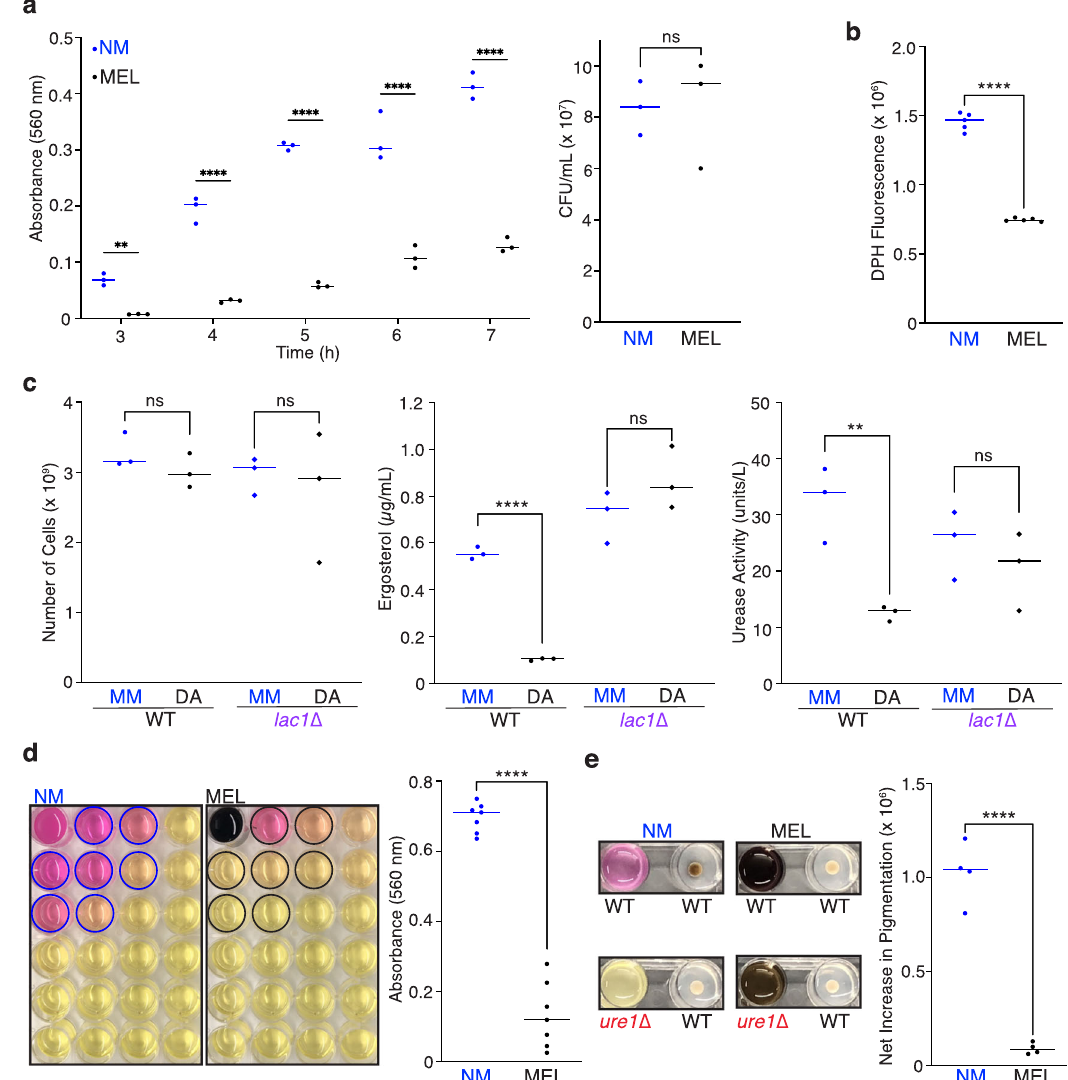
two-sided parametric t -test) and urease activity (right panel; n =3, NS not sig- ni fi cant, ** p =0.0074; unpaired, two-sided p arametric t -test) for WT but not lac1 Δ cellsgrowninthepresenceofDA. d 24-wellplates(left)withNMorMELcellsinurea broth in well A1 (upper left) and pH-sensitive media in remaining wells photo- graphed after incubation at 30°C for 24h. Scatter plot (right) of A 560 for wells within 50mm (outlined with circles) of well A1 indicates signi fi cantly reduced ammonia productionformelanized cells. n =7, **** p <0.0001; unpaired, two-sided p arametric t -test. e WTcellsgrownfor18hat30°Con1mMDA-supplementedagar in wellsadjacent to NM or MEL WT or ure1 Δ cells in urea broth (left panels).Graph (right) of the quanti fi ed net increase in pigmentation reveals signi fi cantly greater stimulationofmelanizationbyNMcomparedtoMELWTcells. n =4,**** p <0.0001; unpaired, two-sided parametric t -test. Source data are provided as a